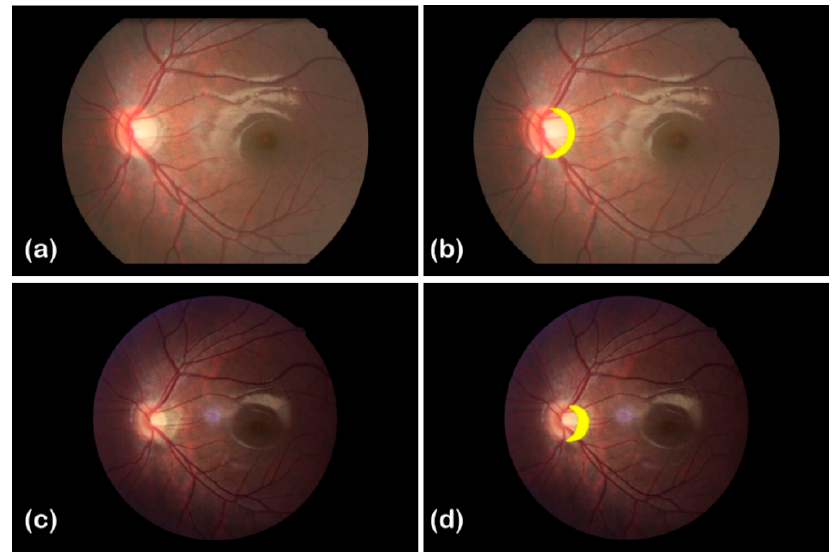
Figure 9. Fundus images of a myopic patient in 2012 and 2016. ( a , c ) are the fundus images taken by Cannon cameras of different models in 2012 and 2016, respectively. ( b , d ) are the labeled versions of ( a , c ), respectively, and show the regions of the atrophic arc highlighted in yellow. The areas of the atrophic arc regions are 17,586 px and 16,521 px in ( b , d ),